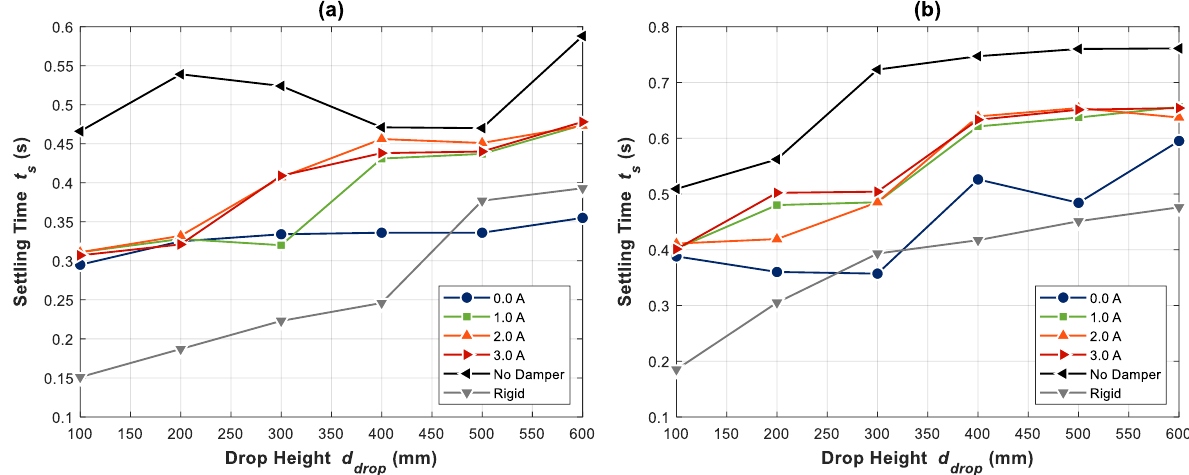
Figure 6. Settling time for impact tests with total masses of ( a ) 2.65 kg and ( b ) 4.60 kg.